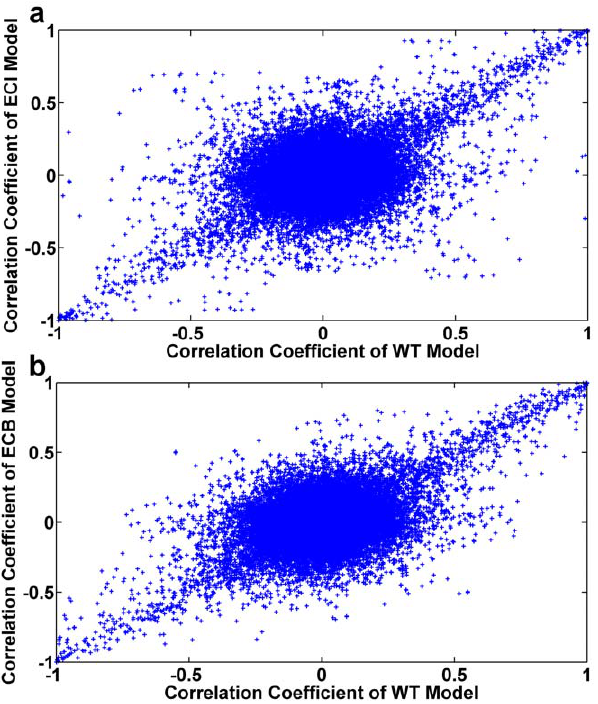
Figure 5. Scatter plots of pairwise correlation coefficients of all fluxes in the metabolic network. (a) Between the wild type (WT) model and the engineered cofactor imbalanced (ECI) model. (b) Between the wild type model and the engineered cofactor balanced (ECB) model.